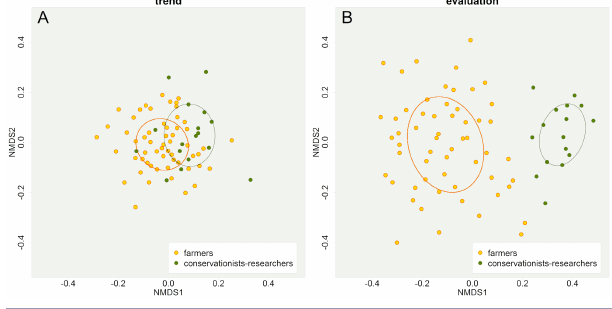
Fig. 2 . Nonmetric Multidimensional Scaling (NMDS) ordination plots for (A) the perceived trends in landscape elements and (B) their